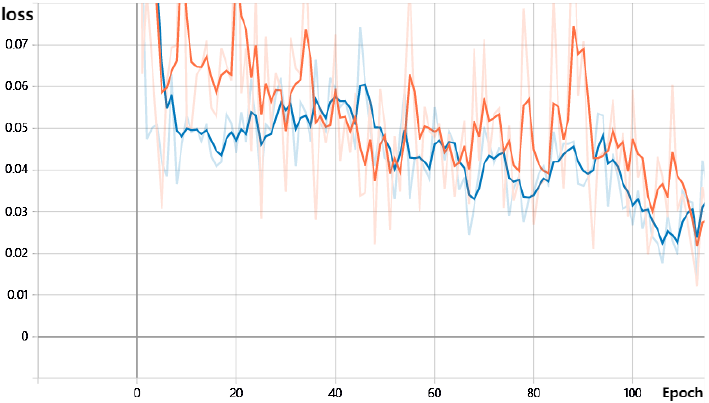
Figure 17. Training loss with fusion